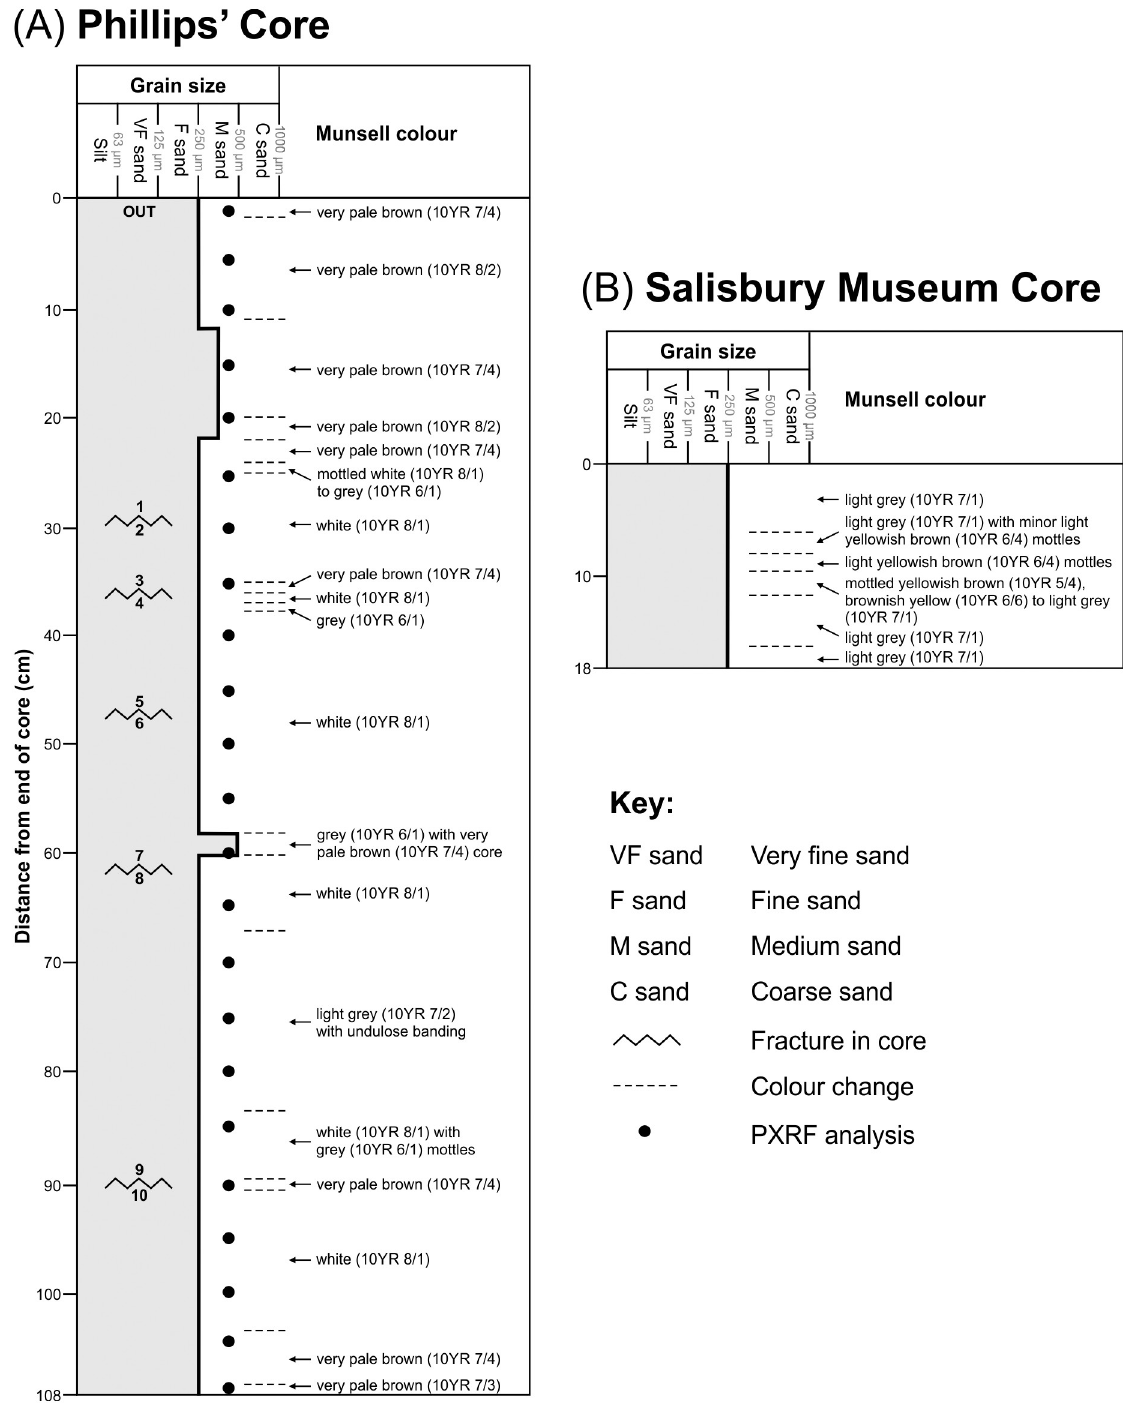
Fig 5. Sedimentary logs of (A) the Phillips’ Core and (B) Salisbury Museum Core from Stone 58 at Stonehenge. Grain size and Munsell colour are plotted with distance from the end of each core. Letter and numbers shown at the end of each section of the Phillips’ Core (i.e. OUT to 10) are those written with marker pen on the original core (see text). Section 2–3 of the Phillips’ Core from 29–36 cm was subject to further detailed petrographical, mineralogical and geochemical analyses.